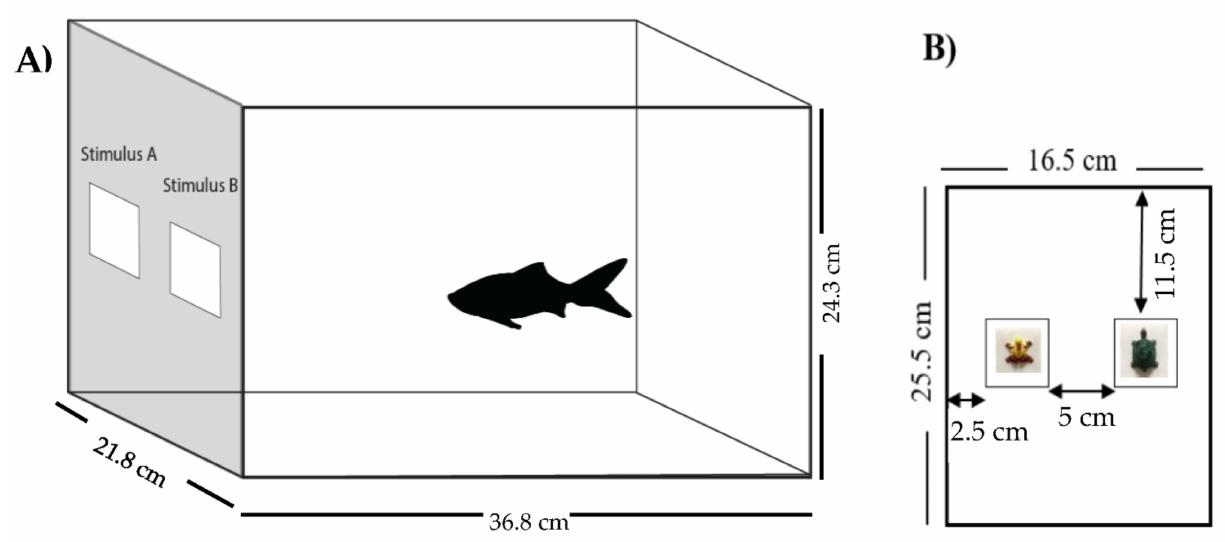
Figure 1. Schematic diagram of the experimental setup. ( A ) Test tank showing the position of the stimulus board and stimuli in the tank. ( B ) The stimulus board containing 0 ◦ stimuli (frog and